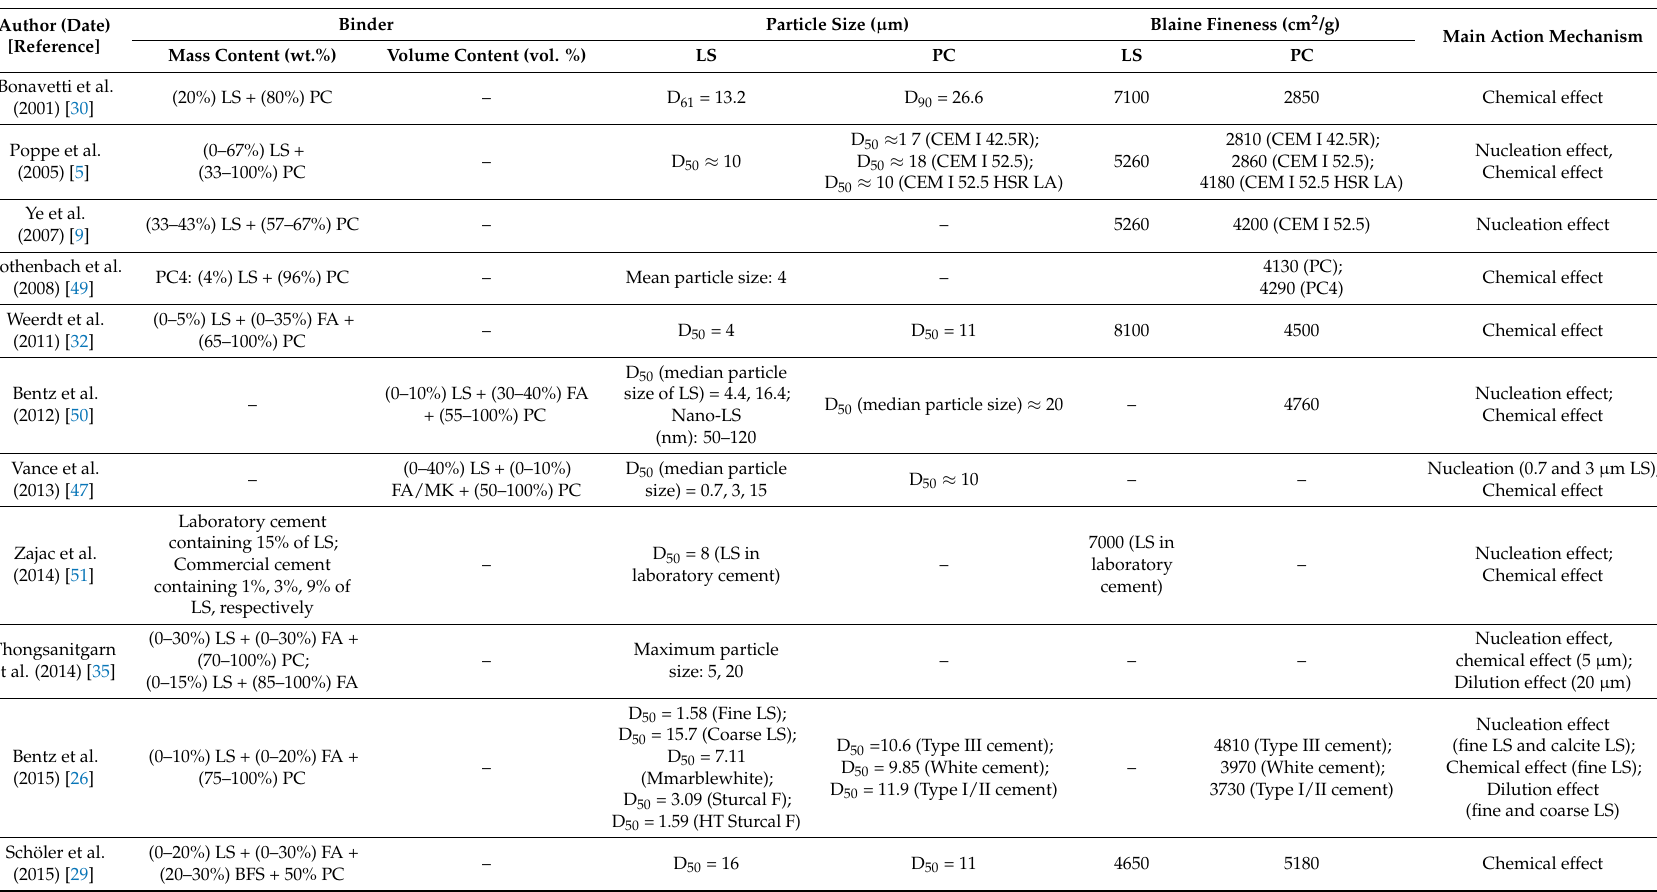
Table 4. Effect of micro-calcium carbonate on cement